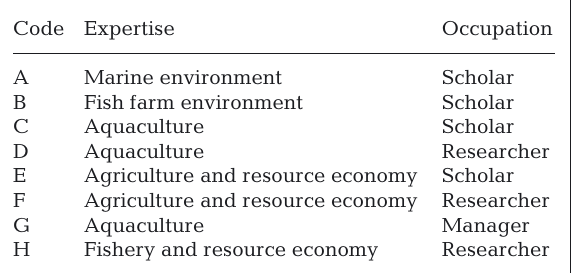
Table 1. Participants in the first round of focus group